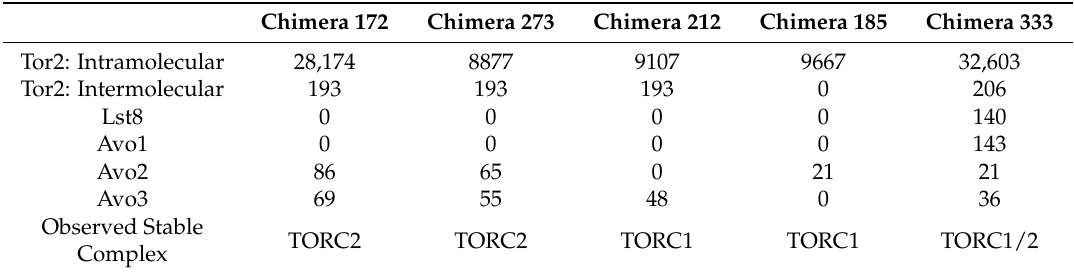
Figure 9. The Tor2 MAS domain of chimera 273 is involved in several quaternary interactions in TORC2. ( A ) Tor2 MAS (chimera 273) (black) mapped onto the cryo EM structure of TORC2 [30]. ( B ) Interactions between Tor2 MAS (black) and Avo2 (green) and Avo3 (red). ( C ) Interactions between Tor2 MAS (black) and Tor2 sequences (red) at the dimer interface. Protein chains are labeled according to nomenclature described in [30]. For clarity, the unstructured region between residues 869-914 in Tor2 in chimera 273 is not displayed. Table 2. Predicted atomic contacts between Tor2-specific sequences and indicated TORC2 components within different chimeras 1